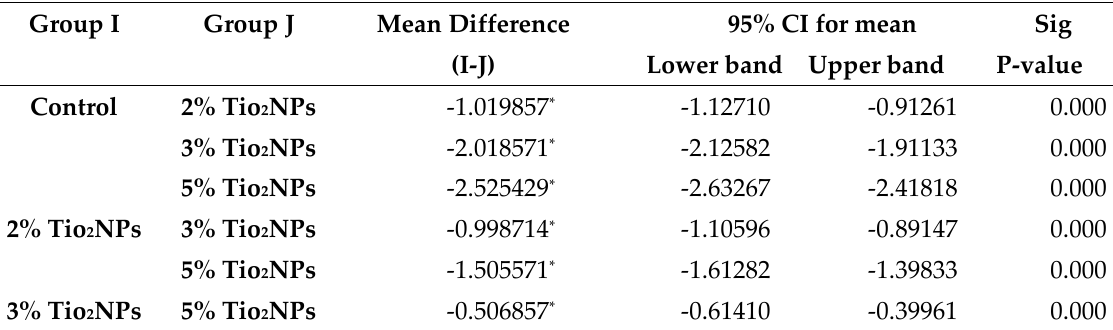
Table 4 : Post hoc test (LSD- multiple comparisons) for S.mutans C.albicans